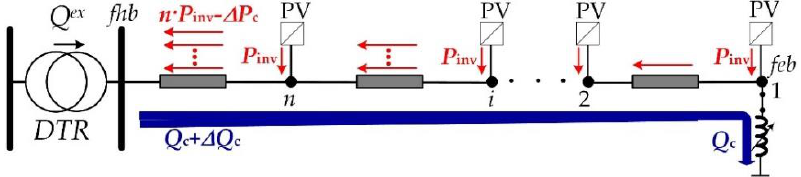
Figure 12. Schematic presentation of the active and reactive power flows when L ( U ) is applied.